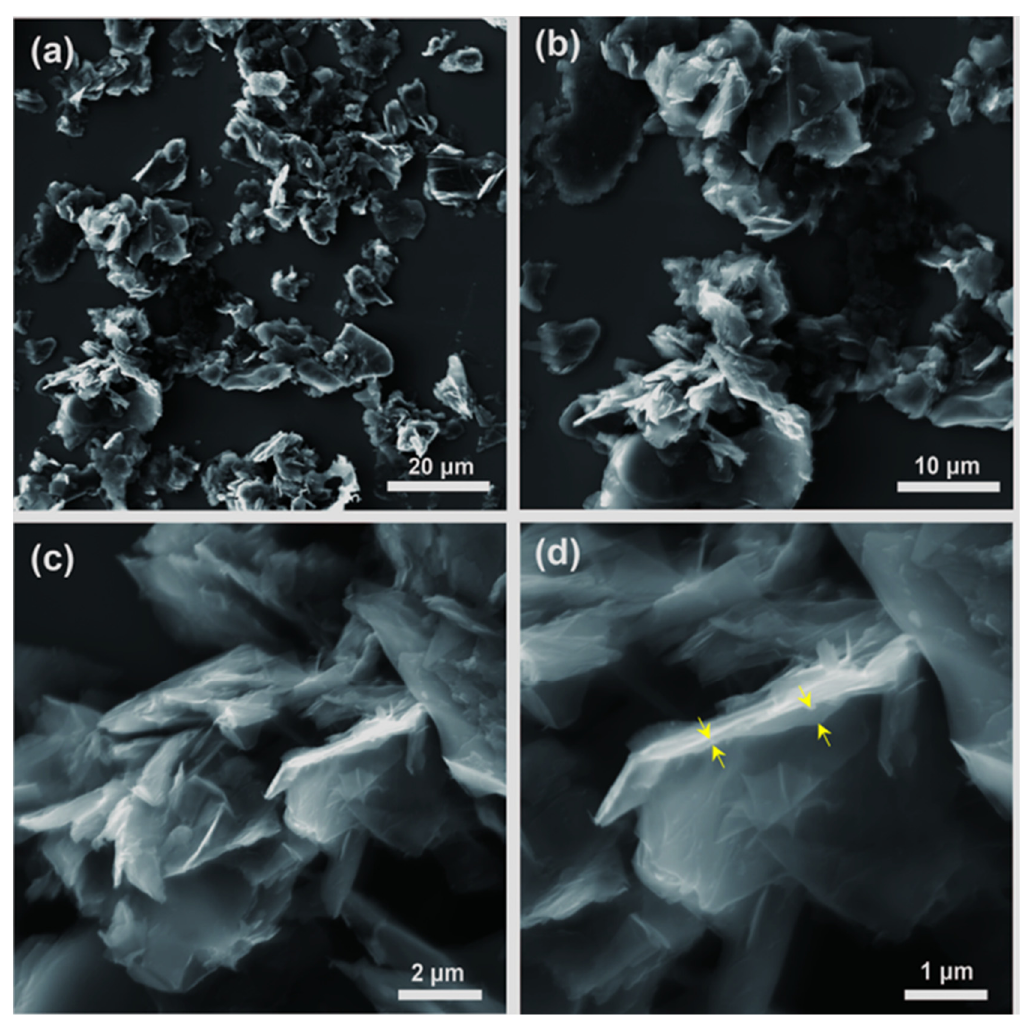
Figure 4. ( a – d ) SEM images of bio-Graphene (yellow arrows show the interlayer space of graphene flakes).